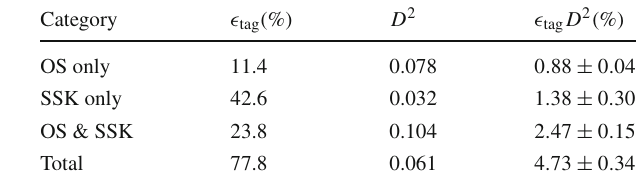
Table 2 Overall tagging performance for B 0 s → J /ψ K + K − . The uncertainty on (cid:19) tag D 2 is obtained by varying the tagging calibration parameters within their statistical and systematic uncertainties summed in